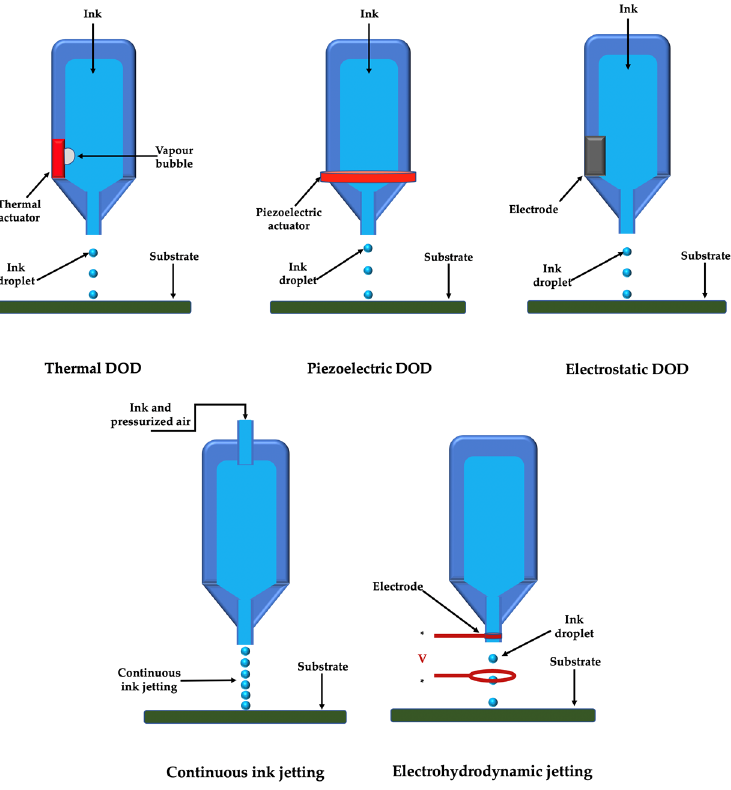
Figure 2. Droplet-based 3D printing techniques; DOD: drop-on-demand.